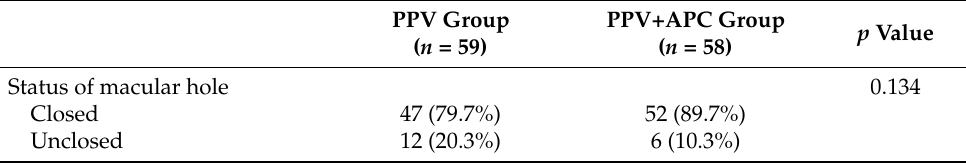
Table 2. Anatomical success rates of macular hole surgery in the two